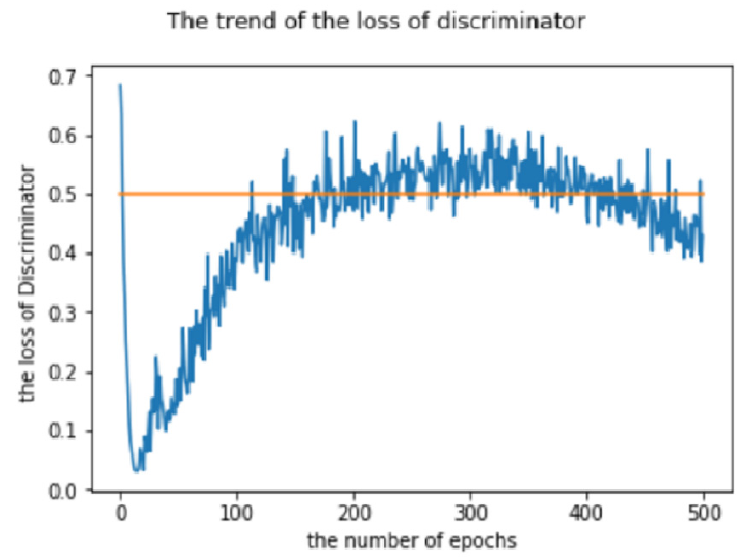
Figure 6. The trend of the loss of discriminator w.r.t. varying values of the number of epochs.